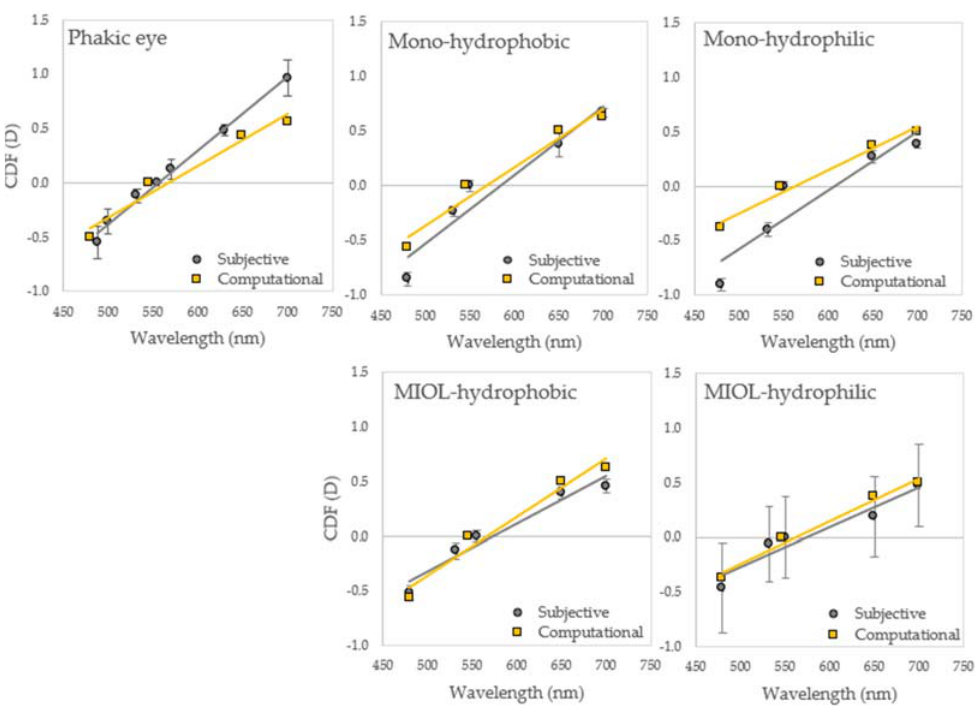
Figure 5. Average chromatic difference of focus (CDF) for far vision. CDF for ( a ) phakic subjects, and for ( b ) monofocal hydrophobic (N = 9), ( c ) monofocal hydrophilic (N = 9), ( d ) multifocal hydrophobic (N = 20), and ( e ) multifocal hydrophilic (N = 20) implanted IOLs, measured with subjective (gray circles), and computational (yellow squares) techniques. Error bars stand for inter-subject variability in all cases.